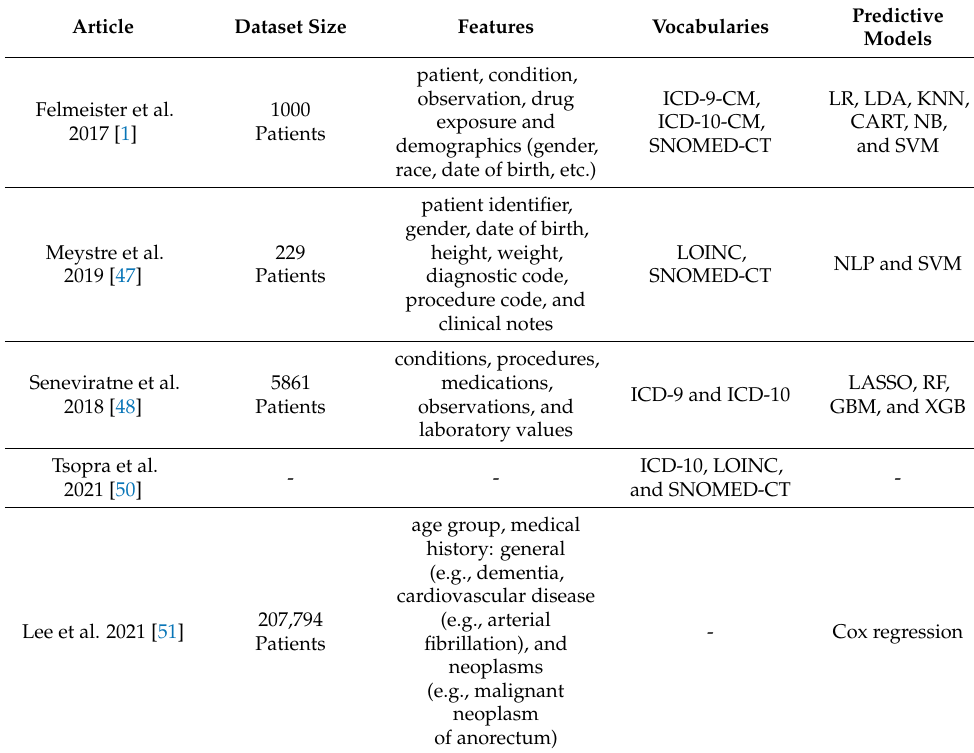
Table 1. An overview of the dataset size and features used in the articles, vocabularies used to transform them into OMOP CDM format, and predictive models used to analyze the